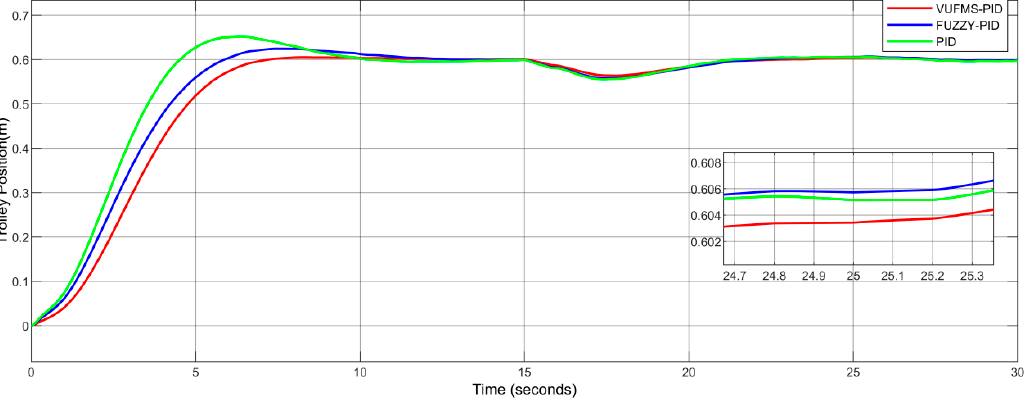
Figure 20. Payload’s swing angle using VUFMS-PID, FUZZY-PID and PID controller under work- ing condition 3 with a crosswind and white noise. Figure 21. Trolley’s position using VUFMS-PID, FUZZY-PID and PID controller under working condition 4 with a crosswind and white noise.